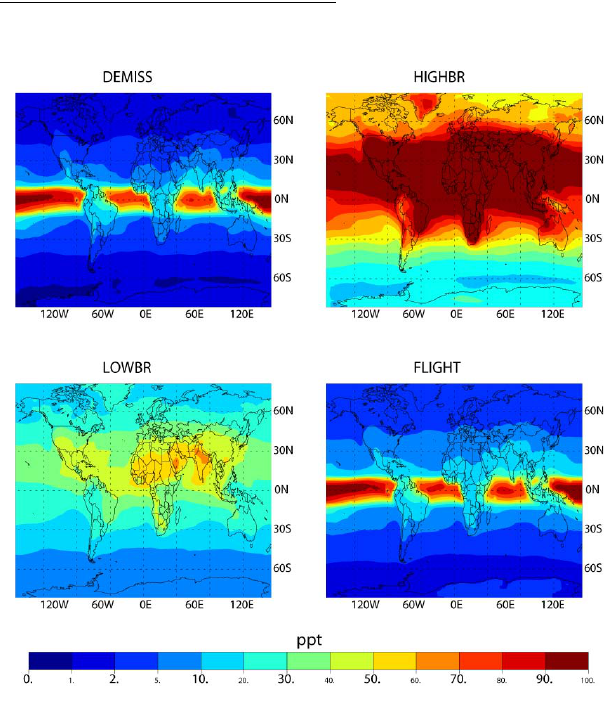
Fig. 3. The annual mean near surface distribution of CH 3 ONO 2 during 2008 for (a) DEMISS, (b) HIGHBR (c) LOWBR and (d) FLIGHT given in